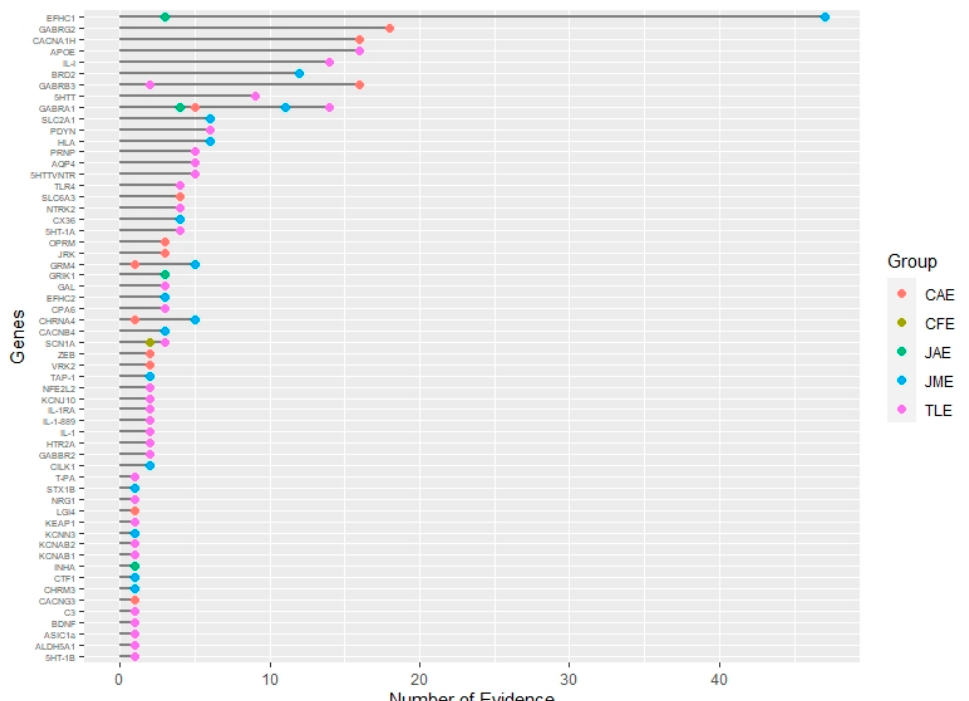
Figure 4. Genomic landscape of common epilepsy subtypes based on evidence. Genes associated with di ff erent subtypes of common epilepsies based on their literature evidence are represented by di ff erent color codes. This figure also shows common and non-overlapping genes associated with di ff erent epilepsy subtypes. CAE: Childhood absence epilepsy, CFE: Cryptogenic focal epilepsy, JAE: Juvenile absence epilepsy, JME: Juvenile myoclonic epilepsy, TLE: Temporal lobe epilepsy.